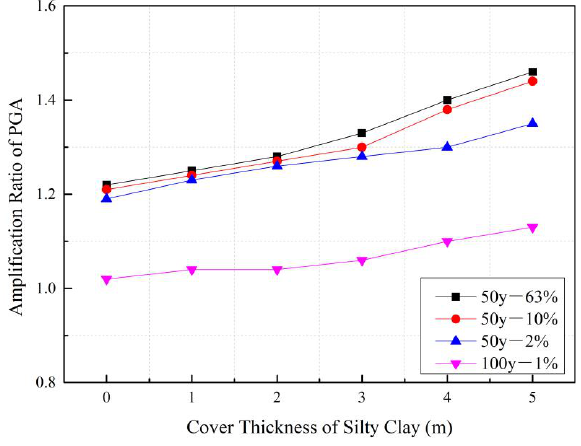
Figure 8. Amplification ratios of ground motion for the different thicknesses of silty clay layer under four seismic inputs.